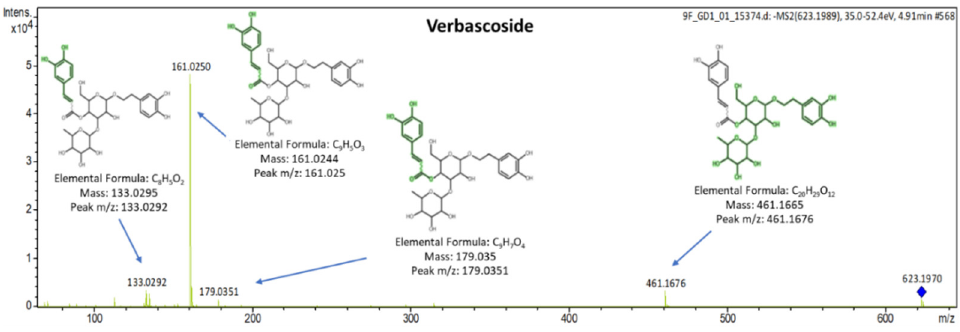
Figure 7. MS/MS spectrum of verbascoside identified in leaves with explained fragments. Figure 7. MS / MS spectrum of verbascoside identified in leaves with explained